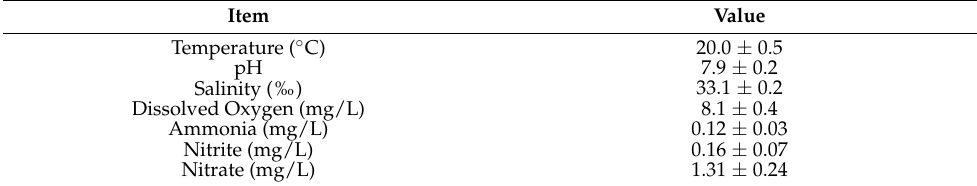
Table 1. The chemical components of seawater and experimental condition used in the